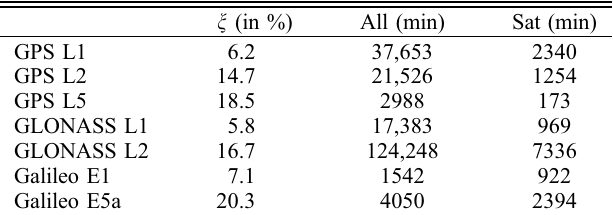
Table 3. Aggregated statistics of scintillation occurrence for 2013. The first column gives an estimates of the overall influence of amplitude scintillations on the signals. The column ‘‘all’’ gives the total number of minutes with scintillations occurring as given by the algorithm in Figure 3. The column ‘‘sat’’ gives the average time a satellite that crossed Bahir Dar during times of scintillations was disturbed for 2013.